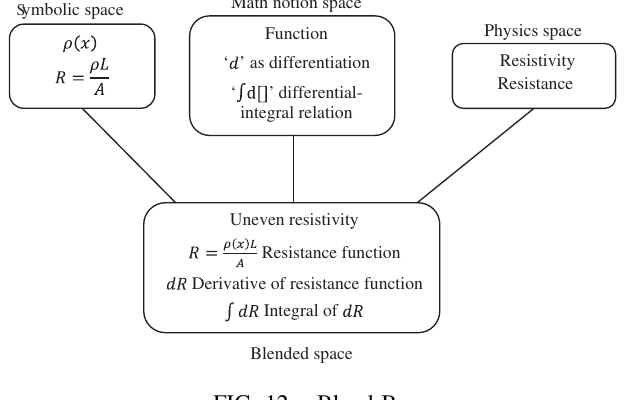
FIG. 12. Blend B. FIG. 13. Equation set up by